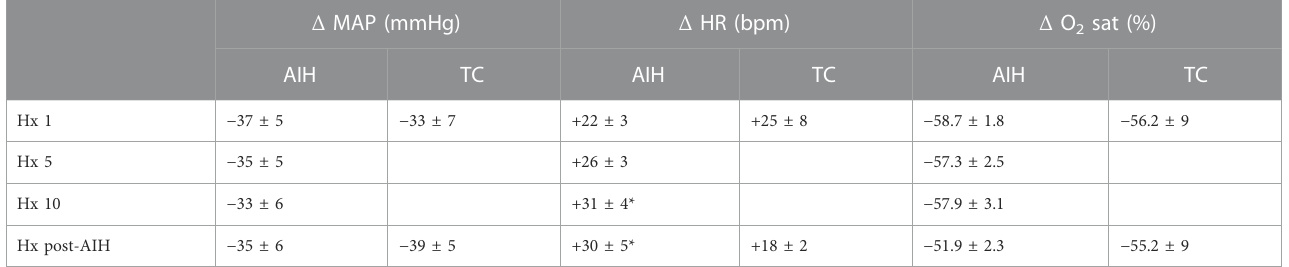
TABLE 2Meanchanges inMAP,HR andO 2 saturation during hypoxia. Responses are shownfor Hx 1,5,10 andHx post-AIH for AIH (left)and TC (right). Changes due to Hx were calculated relative to baseline immediately before each episode of hypoxia. AIH: One-way repeated measures ANOVA, * vs. Hx 1; TC: paired t -test. Δ MAP (mmHg) Δ HR